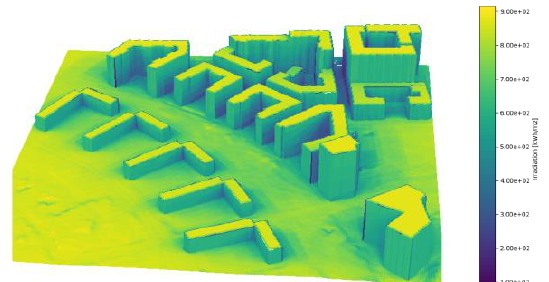
Figure 6. Annual solar irradiation values of the buildings in the study area simulated by